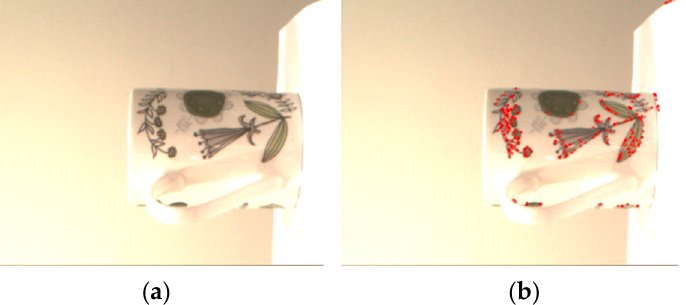
Figure 20. ( a ) A 640 × 480 image for evaluating the proposed E-SIFT; ( b ) feature points detected.